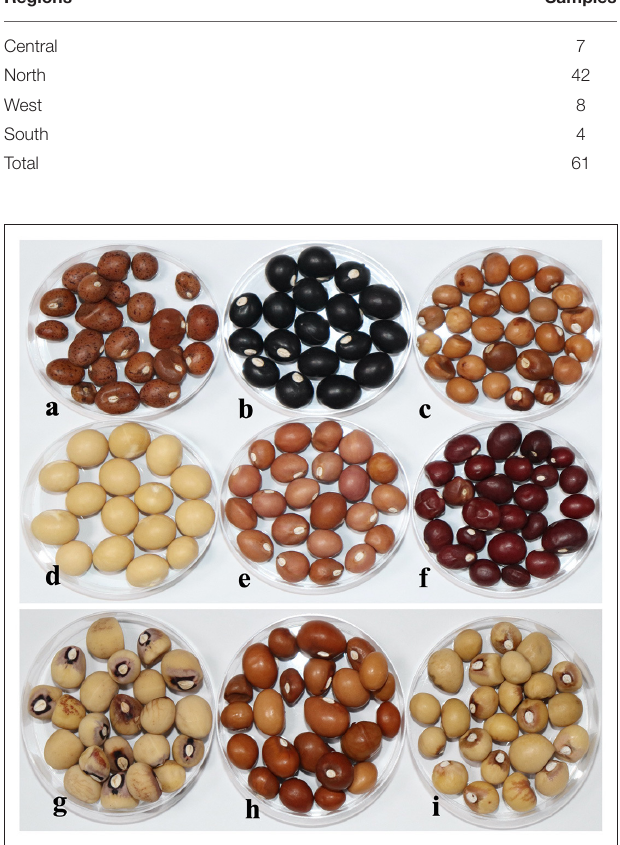
TABLE 2 | Bambara groundnut samples collected in four different regions of Cameroon in the year 2019. Regions